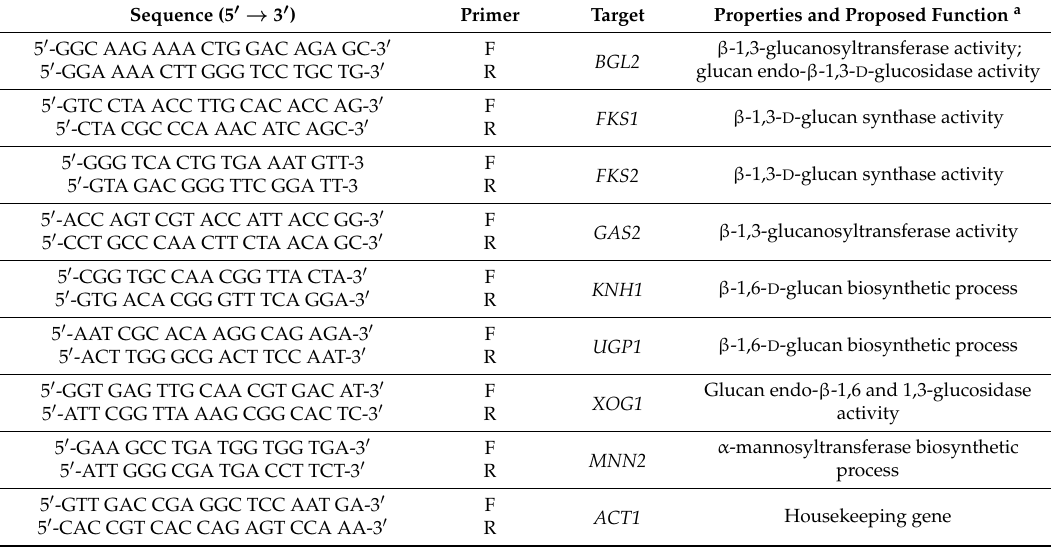
Table 2. Primers, targets used, and specific function of the genes used for the expression analysis. Sequence (5 (cid:48) → 3 (cid:48) ) Primer Target Properties and Proposed Function